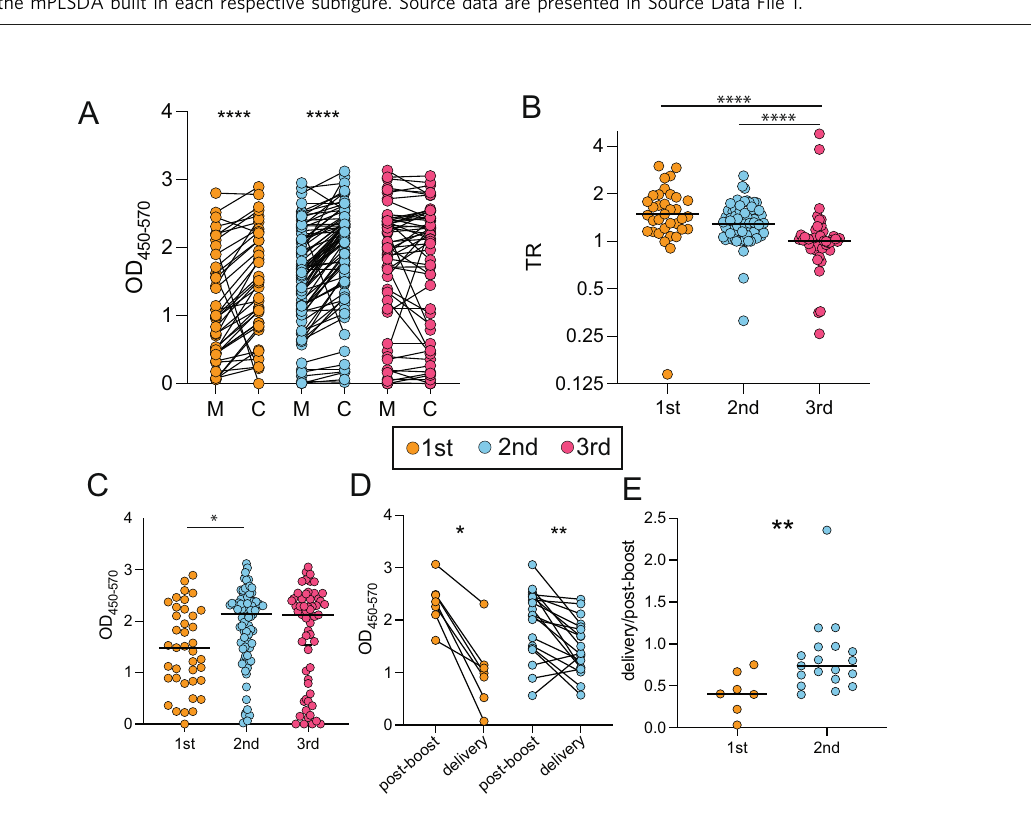
Fig. 4 Ef fi cient transfer of vaccine-induced antibodies to cord blood. A The dot plots show the Spike-speci fi c IgG1 titer or FcR3a binding for maternal plasma (M) and cord blood (C). Lines connect maternal-cord dyads and the color represents vaccine type, Ad26.COV2.S (red), mRNA-1273 (yellow) or BNT162b2 (blue). Signi fi cance was determined by Wilcoxon signed-rank test (2-sided) followed by posthoc Benjamini – Hochberg correction adjustment, * p < 0.05, ** p < 0.01, *** p < 0.001. Exact p -value for FcR3a: mRNA-1273 p = 0.0000052, BNT162b2 p = 0.042. B The dot plots show the Spike-speci fi c antibody-dependent cellular phagocytosis (ADCP), antibody-dependent neutrophil phagocytosis (ADNP), antibody-dependent complement deposition (ADCD), and antibody-dependent NK cell degranulation, as measured by % CD107a + NK cells, for maternal plasma (M) and cord blood (C). Lines connect maternal-cord dyads and the color represents vaccine type, Ad26.COV2.S (red), mRNA-1273 (yellow) or BNT162b2 (blue). Signi fi cance was determined by Wilcoxon signed-rank test (2-sided) followed by posthoc Benjamini – Hochberg correction adjustment, * p < 0.05, ** p < 0.01, *** p < 0.001. Exact p -values stated in the following order for all subpanels: mRNA-1273 M-C, then BNT162b2 M-C, unless otherwise noted. ADCP: p = 0.00011, p = 0.0066. ADNP: p = 0.00007, p = 0.0099. ADCD: BNT162b2 p = 0.011. CD107a + : p = 0.00021, p = 0.047. C – E A multilevel PLSDA (mPLSDA) was built for Ad26.COV2.S ( C ), mRNA-1273 ( D ) and BNT162b2 ( E ) using sample type, maternal blood (M, light purple) or cord blood (CB, dark purple) as the outcome variable. Features were selected using LASSO prior to building the models. The dot plots (top) show the scores plots for the mPLSDA. Each dot represents a sample, with the color representing the sample type. The ellipses represent the 95% con fi dence interval for the sample type. The bar plots show the LV1 for the mPLSDA built in each respective sub fi gure. Source data are presented in Source Data File 1.